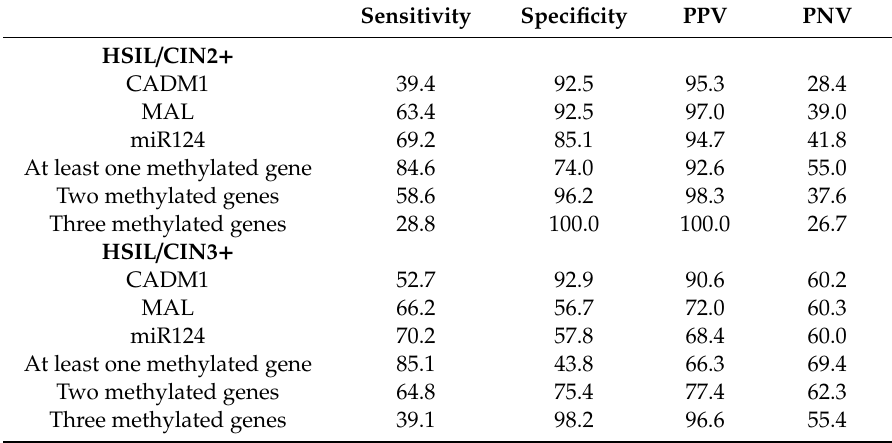
Table 2. Sensitivity, specificity, positive, and negative predictive values (PPV and NPV, respectively) of the methylation of MAL, CADM1, or miR-124, and of at least one, two, or the three genes for HSIL / CIN2 + and HSIL / CIN3 + . HSIL / CIN2 + includes high-grade squamous intraepithelial lesion / cervical intraepithelial neoplasia grade 2 (HSIL / CIN2), HSIL / CIN3 and cervical cancer (CC). HSIL / CIN3 + includes HSIL / CIN3 and